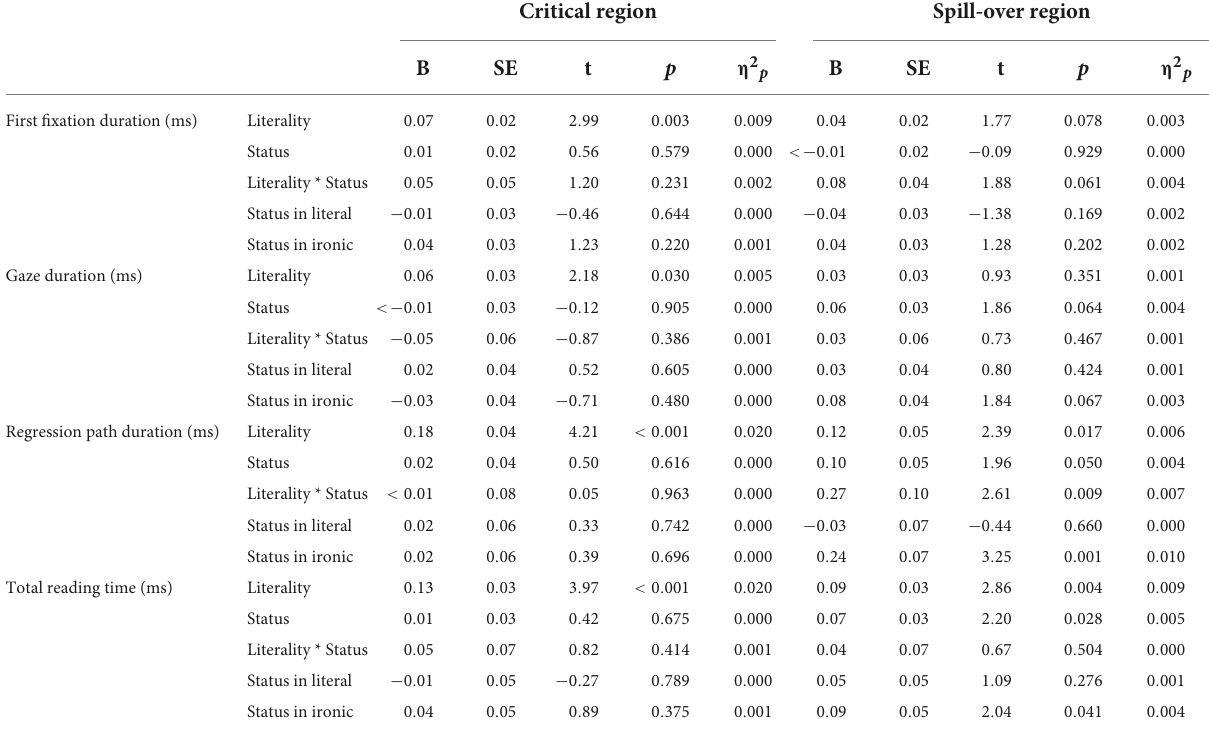
TABLE 2 Summary of linear mixed